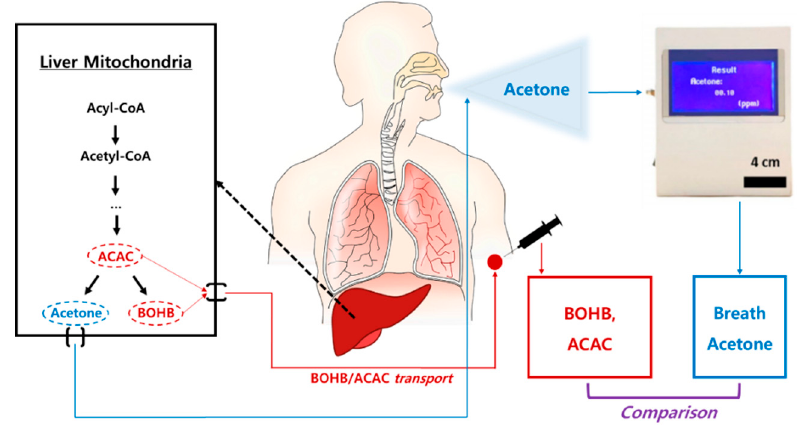
Figure 4. The flow of ketone bodies and their measurements.